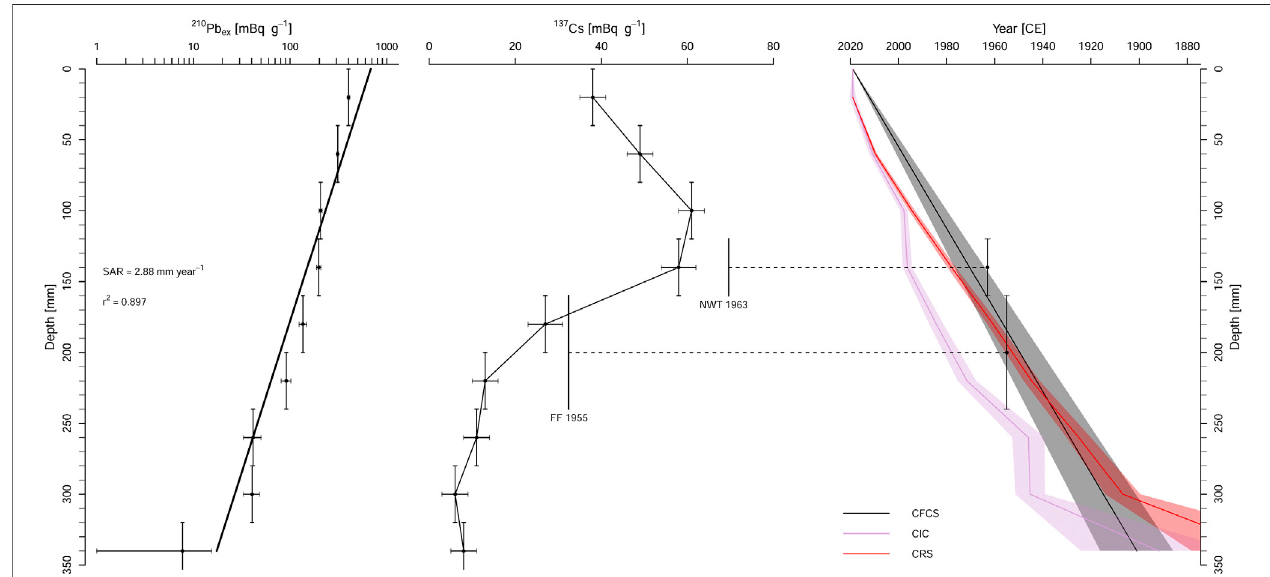
FIGURE2| Short-livedradionuclideactivities and age-depthmodelsfor theSUZ3core.Fromlefttoright: 210 Pb ex activity (semilogarithmic plot), 137 Csactivity, and the Constant Flux Constant Sedimentation rate (CFCS), Constant Initial Concentration (CIC), and Constant Rate of Supply (CRS) age-depth models. SAR — sediment accumulation rate, NWT 1963 — nuclear weapon tests fallout, FF 1955 — fi rst fallout period. The vertical error bars refer to analyzed sediment sample thickness (4 cm), while the horizontal bars depict 2-sigma uncertainty.